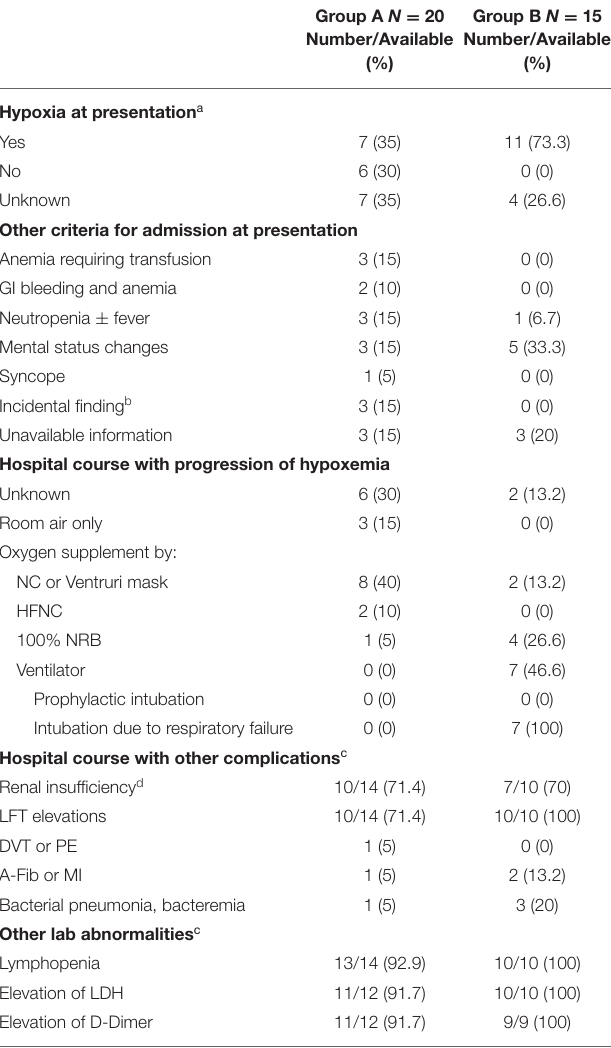
TABLE 4 | Presentation and admission criteria for admitted patients, as well as their hospital course and